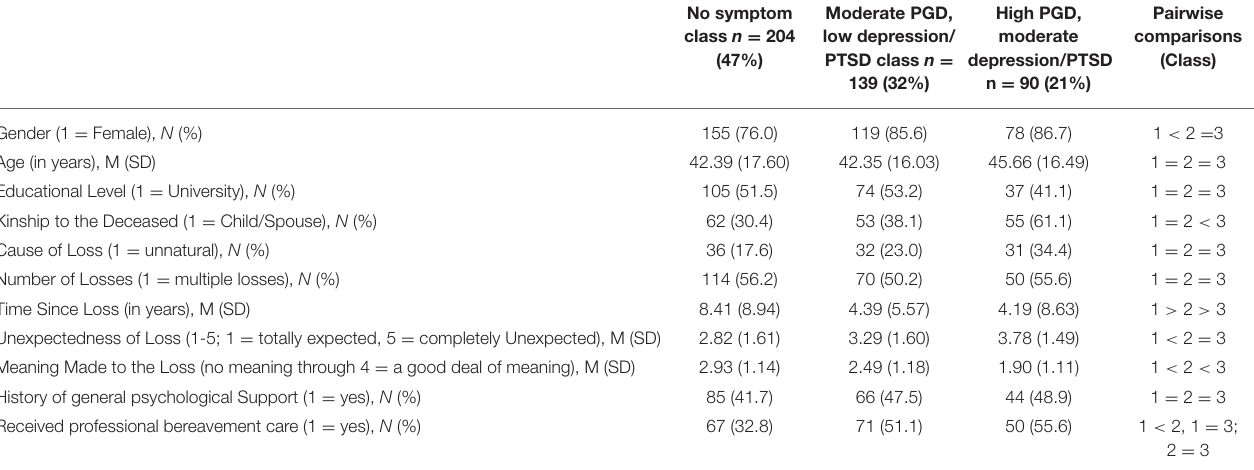
TABLE 4 | Correlates of class membership in multivariate